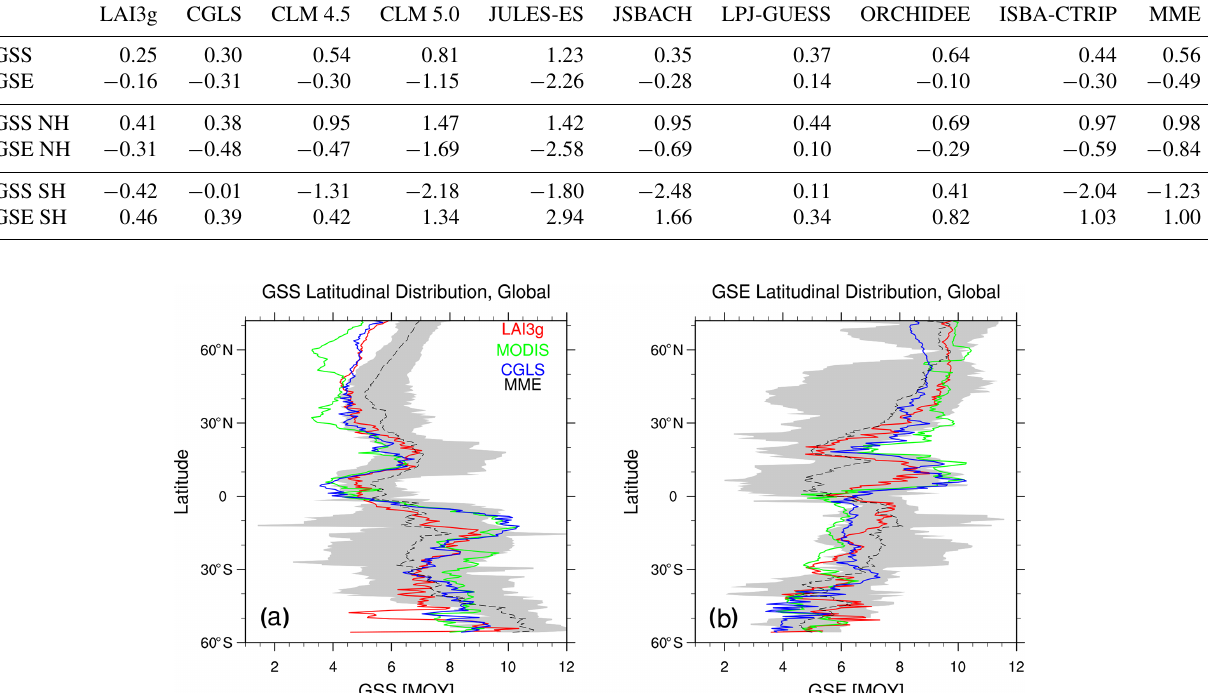
below 40 ◦ S. The reduced amount of vegetated land area